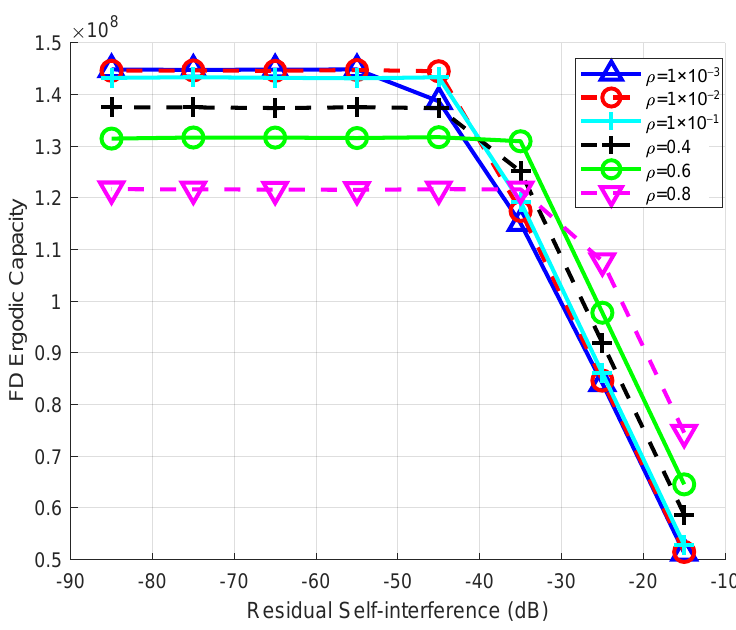
Figure 10. Capacity comparison of full-duplex with PS factor. As shown in Figure 11, we found that in the full-duplex DF system, the outage probability decreases with the increase of the PS factor and residual interference. This is consistent with the change of the system capacity curve.